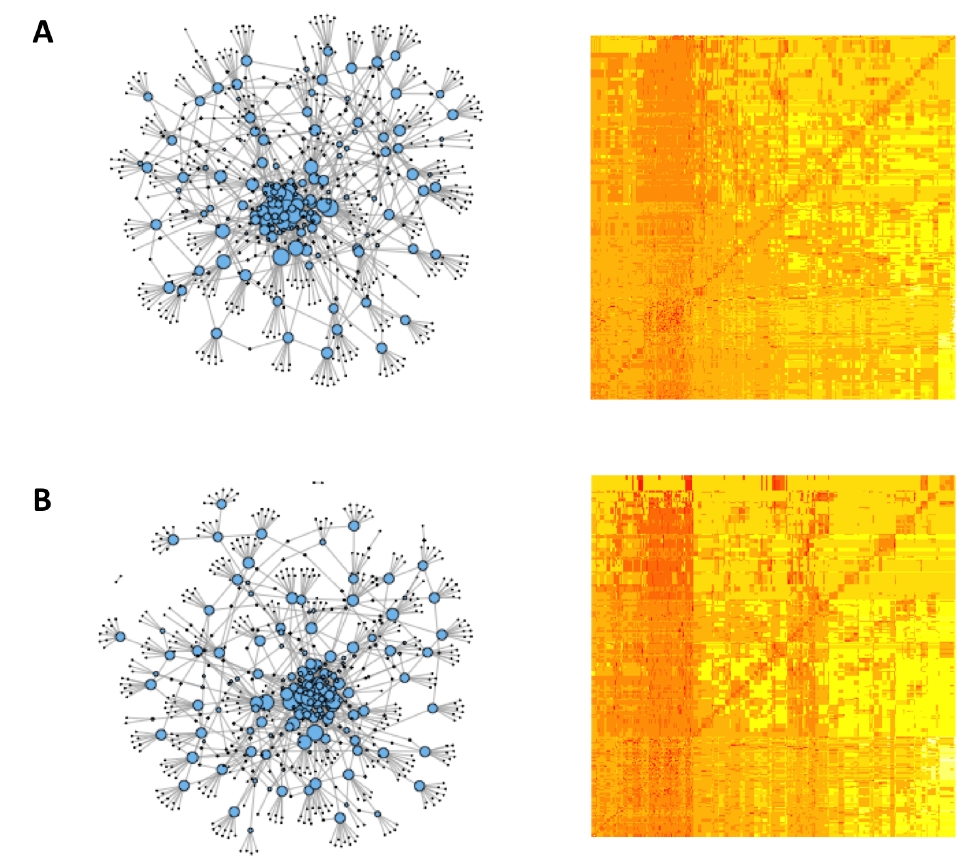
Figure 3. We analyze an Internet peer-to-peer network representing Gnutella file exchanges on two consecutive days (8 and 9 August 2002, from [34,35]); ( A ) Network plot (left) and curvature map (right) displaying the distribution of Forman curvature for a Gnutella snapshot on 8 August; ( B ) Analogous plots for a Gnuttela snapshot from the following day, 9